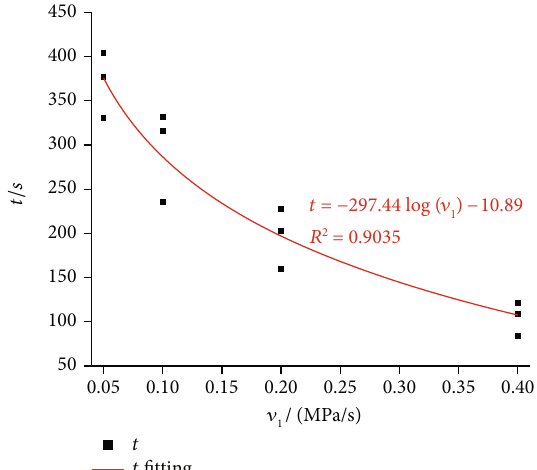
Figure 6: Relationship between failure time and loading axial pressure rate.